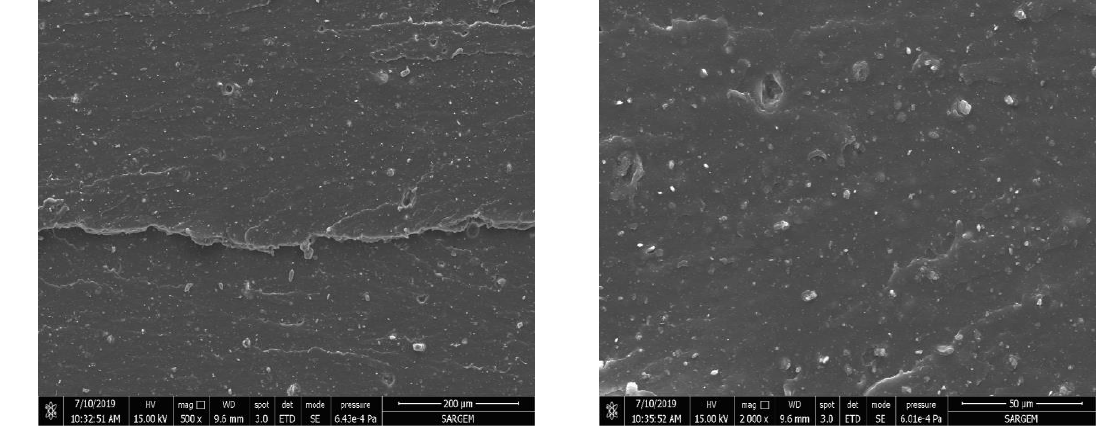
Figure 5. Tensile fractured surface morphologies of the EPDM/Silica composites prepared in MC 15 HT (magnification × 500 and × 2000).